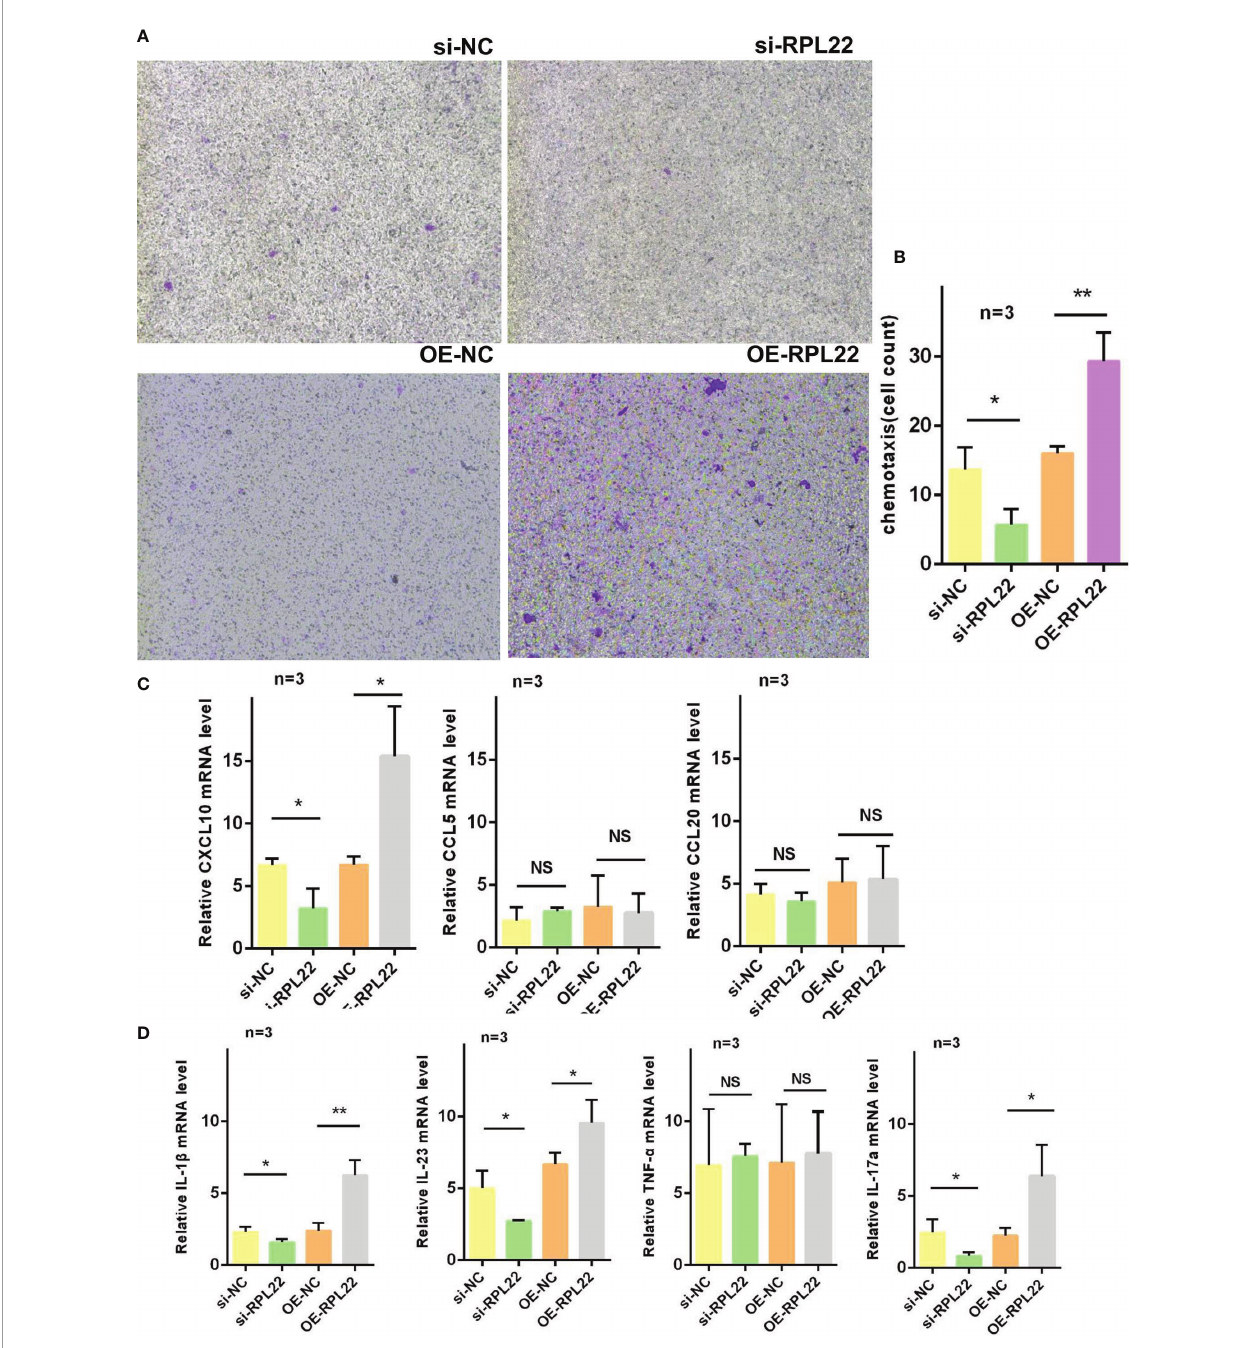
FIGURE 5 | RPL22 promotes cell chemotaxis. (A) Chemotaxis assay to detect the chemotaxis ef fi ciency of KCs transfected with si-RPL22 or OE-RPL22 and their controls on CD4 + T cells (n = 3). (B) Cell count to statistically analyze the chemotaxis differences (n = 3). (C) RT-qPCR to detect the mRNA levels of chemokines of KCs transfected with si-RPL22 or OE-RPL22 and their controls including CXCL10, CCL5 and CCL20 (n=3). (D) RT-qPCR to detect the mRNA levels of psoriasis- associated cytokines of KCs transfected with si-RPL22 or OE-RPL22 and their controls including IL-1 b , IL-23, TNF- a and IL-17a (n = 3). All data are representative of at least 3 independent experiments. Data represent the mean ± SEM. *P < 0.05, **P < 0.01. NS, not signi fi cant. Two-tailed unpaired Student ’ s t test was